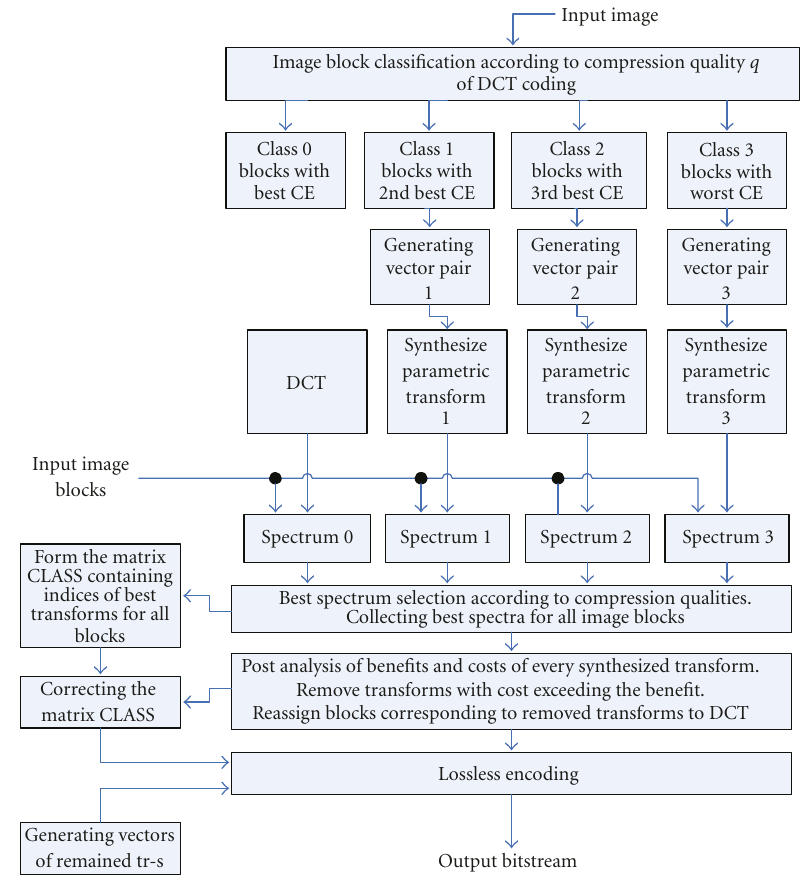
Figure 7: Multiple transform-based image coder.